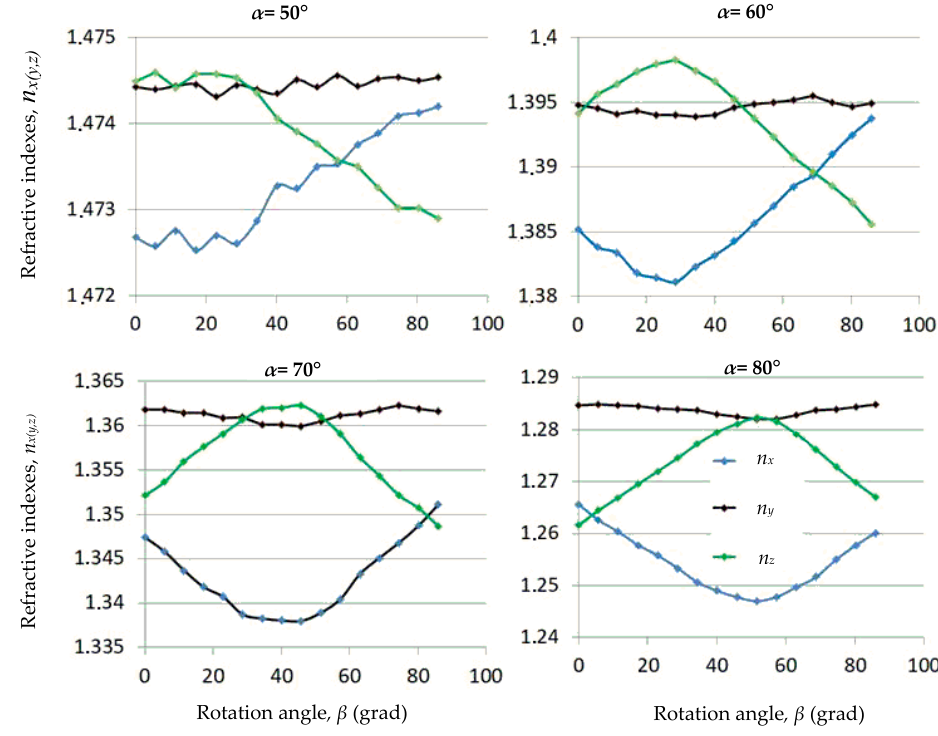
Figure 8. Dependences of the di ff erence of the refractive index main components on the rotation angle for di ff erent values of the deposition angle α . Table 2. Dependencies of the di ff erence between the components of the refractive index ∆ n